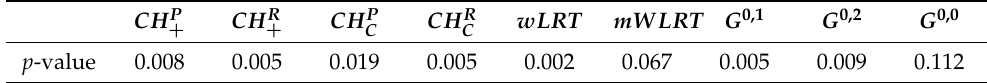
Table 8. p -values of the tests for the kidney infection data. wLRT mWLRT G 0,1 G 0,2 G 0,0 CH P + CH R + CH P CH R C C p -value 0.008